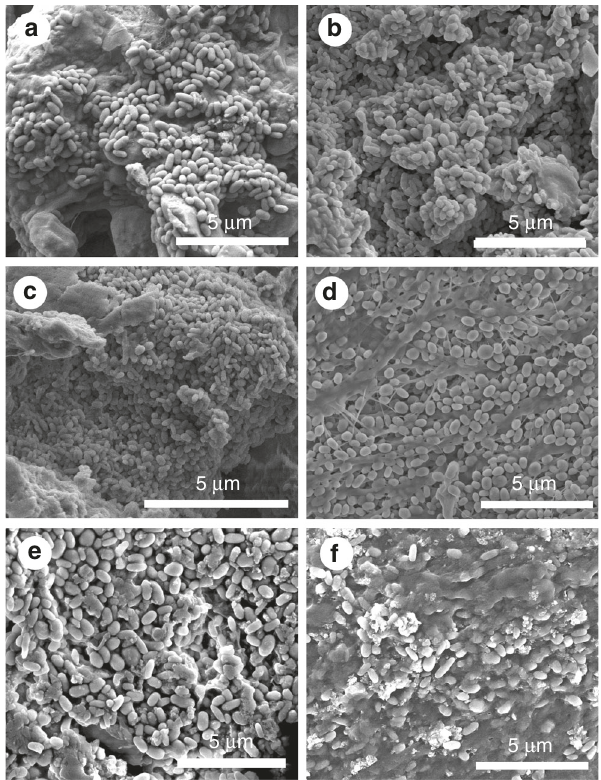
Fig. 6 Melanosomes in extant reptiles. Scanning electron micrographs of extant black iguana ( Ctenosaura similis (Squamata: